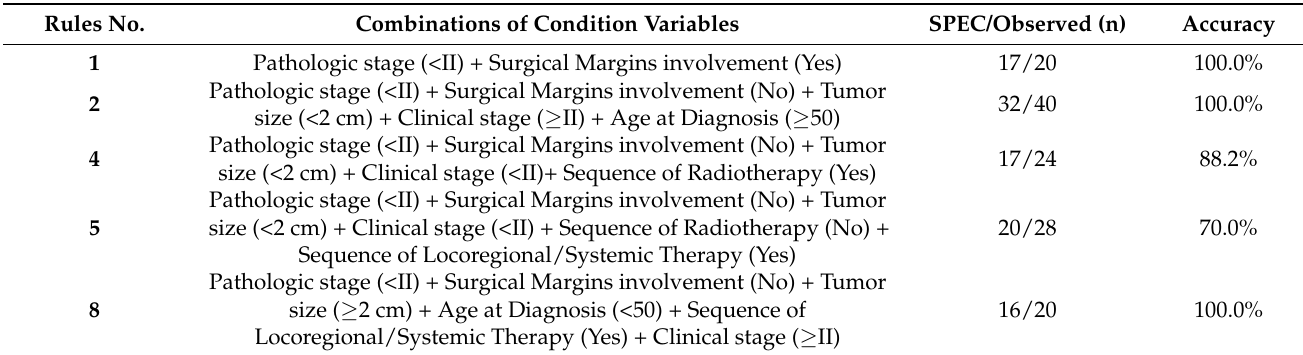
Table 5. The summarized rules of condition variables (BMI > 25 kg/m 2 ).